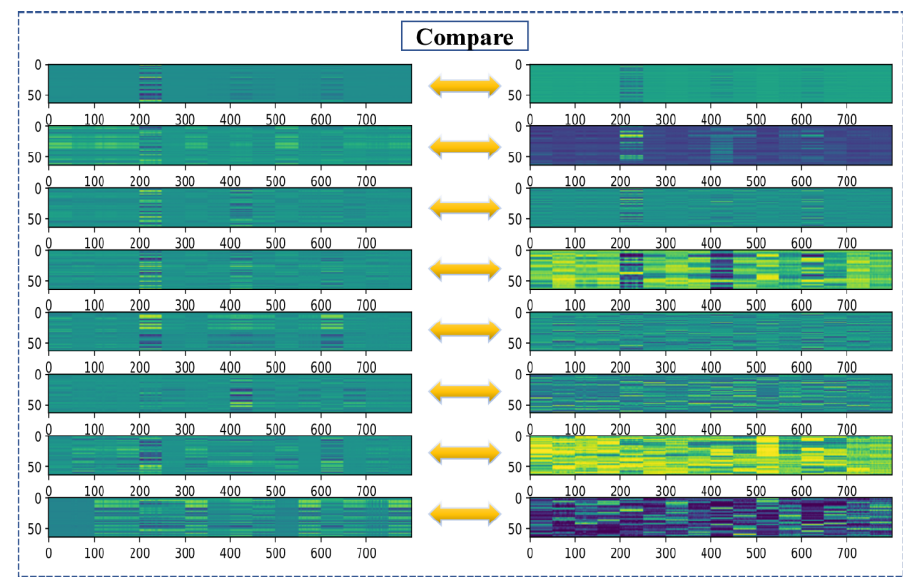
Figure 9. Visual comparison of weights for ResNET-FCF and SE blocks.